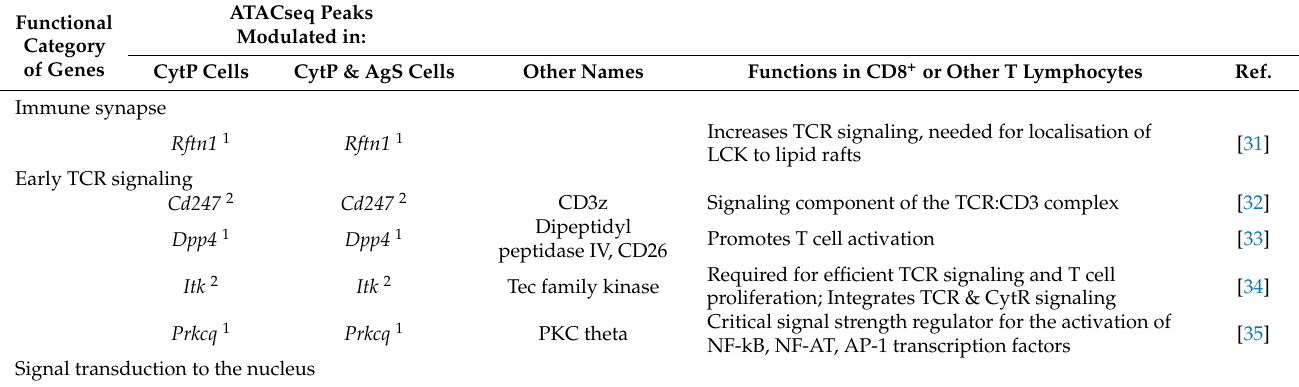
Table 2. Genes related to T lymphocyte activation, regulation and functions that are adjacent to the opening and closing ATACseq peaks in CytP and in both CytP and AgS CD8 + T